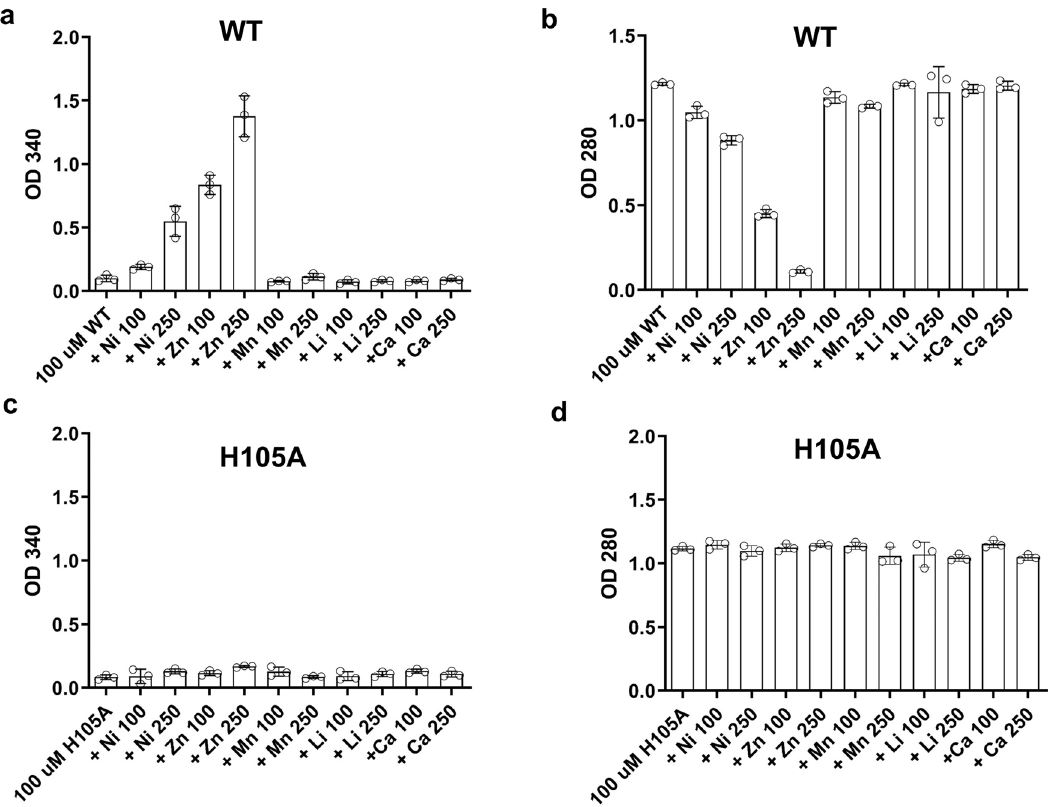
Fig. 6 UV-spectroscopy studies of hCEACAM1 IgV WT and H105A mutant with various metal ions. a Titration of hCEACAM1 WT 100 µ M (with buffer) and with various metals (Ni ++ , Zn ++ , Mn ++ , Li + , Ca ++ ) at 1:1 and 1:2.5 ratio. OD analysis at 340 nm revealed Zn ++ or Ni ++ caused concentration dependent aggregation of the hCEACAM1 WT protein after 30-minute incubation. b OD analysis of supernatant after centrifugation at 280 nm for WT protein and with various metals (Ni ++ , Zn ++ , Mn ++ , Li + , Ca ++ ) at 1:1 and 1:2.5 ratio. c Titration of H105A mutant 100 µ M (with buffer) and with various metals (Ni ++ , Zn ++ , Mn ++ , Li + , Ca ++ ) at 1:1 and 1:2.5 ratio. OD analysis at 340 nm revealed no Zn ++ or Ni ++ mediated aggregation observed for the H105A mutant protein. d OD analysis of H105A mutant supernatant after centrifugation at 280 nm alone and with various metals (Ni ++ , Zn ++ , Mn ++ , Li + , Ca ++ ) at 1:1 and 1:2.5 ratio. The mean values with standard deviations are shown in bar graph with error bars of the triplicate samples. Source data are provided in Supplementary Data